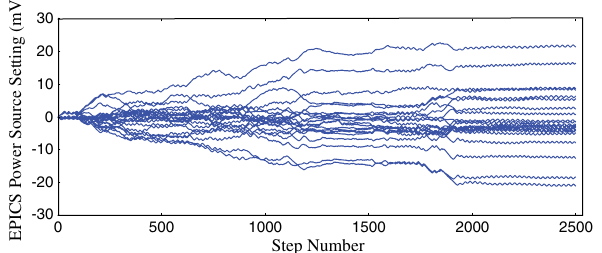
FIG. 5. Evolution of the magnet current settings to the magnets over 2500 iteration steps.